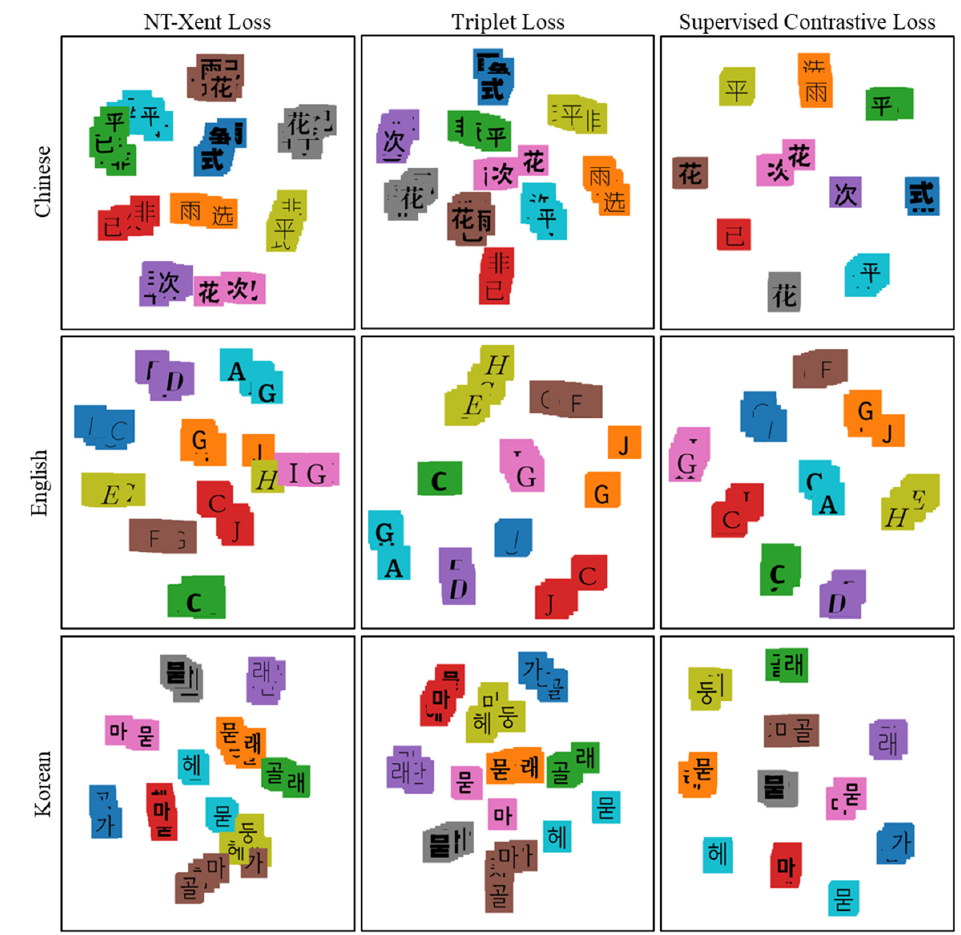
Figure 5. t-SNE Projections of Chinese, English, and Korean embeddings vectors models trained using NT-Xent, Triplet loss and supervised contrastive loss. Images with the same color represent the same font style.